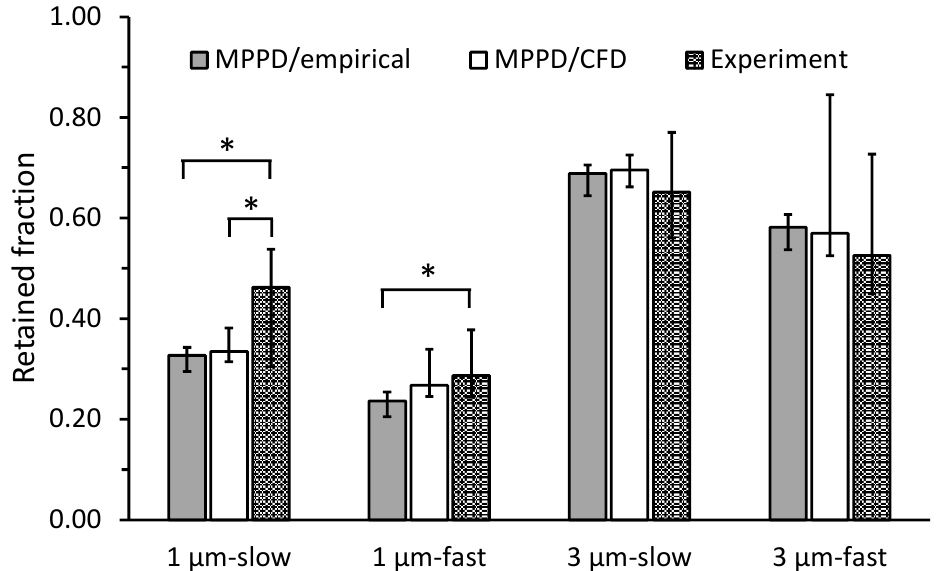
Figure 8. Comparison of retained fraction predicted by the MPPD/empirical and MPPD/CFD models with measurements of Darquenne et al. [20]. In silico predictions were obtained for subject-specific breathing conditions matching the experiments. Data are shown as the median (minimum, maximum) of the 7 healthy subjects. *: significantly different from experiments ( p < 0.02). See text for details.